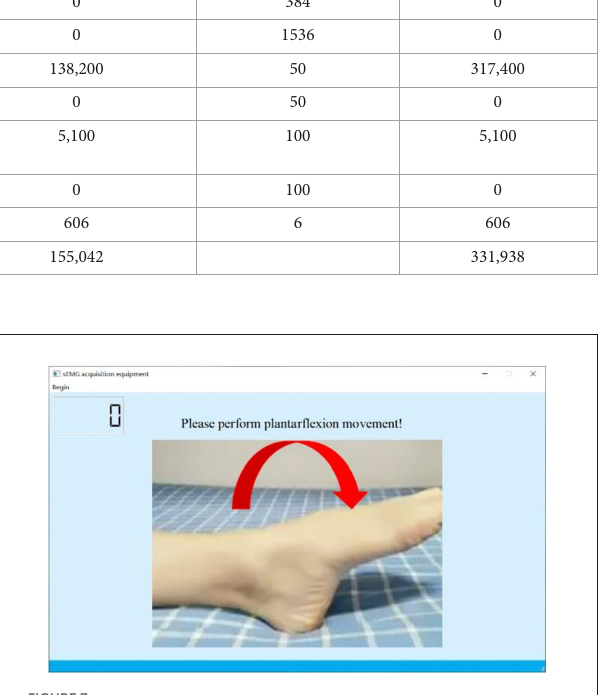
FIGURE7 Screenshot of the guidance interface of the experiment.